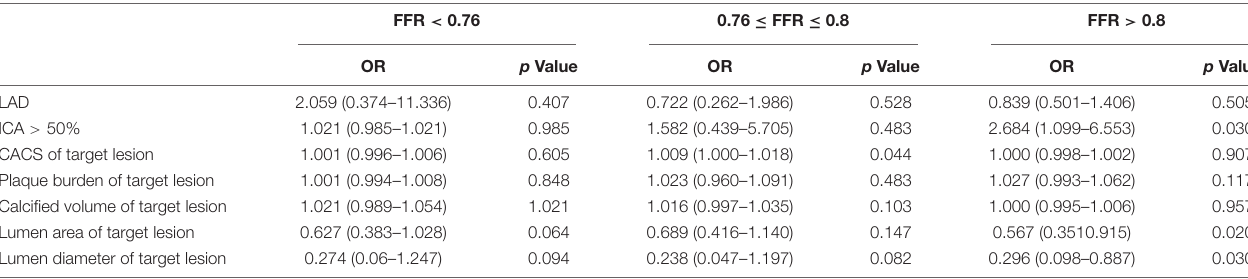
TABLE 6 | Univariate logistic regression analysis of the effects of CTA characteristics on FP and FN lesions by CT-FFR in different FFR